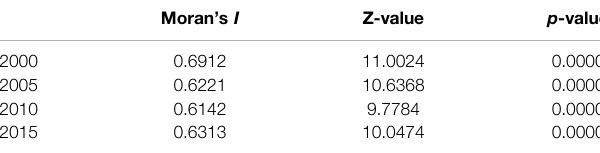
TABLE 4 | Moran ’ s I test results for soil erosion in Shaanxi, 2000 –